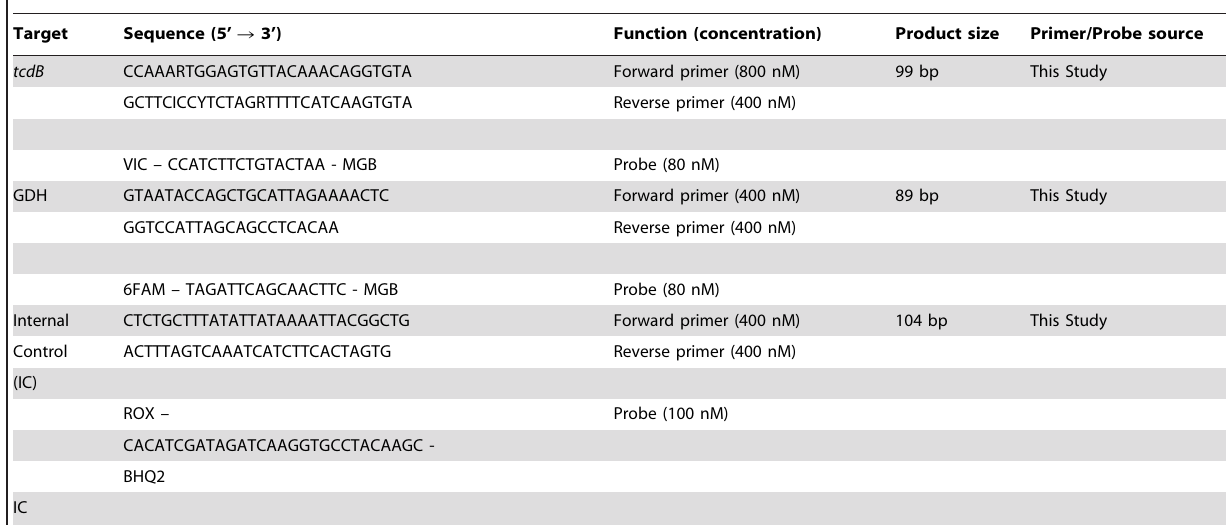
Table 1. Primers and probes used for real-time